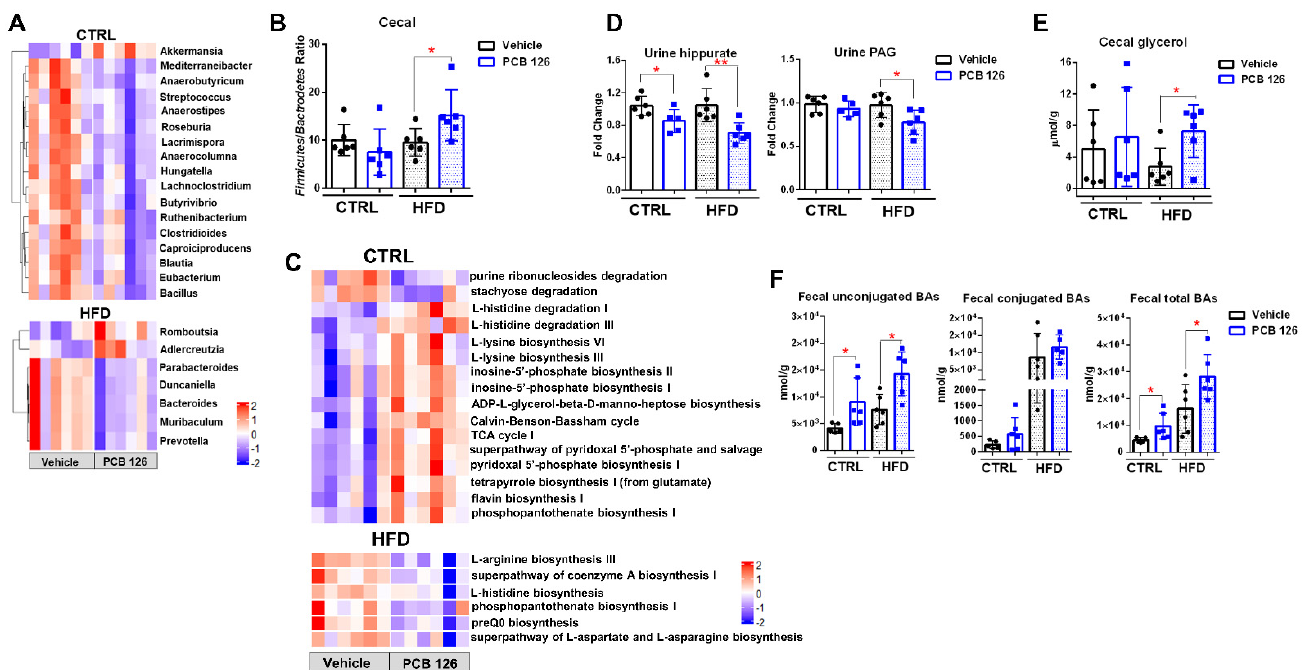
Figure 5. Effects of early life PCB 126 on bacteria community and metabolism in mice with CTRL or HFD. ( A ) Heatmap representation of the abundance of cecal bacteria from genera that were significantly changed from CTRL or HFD-fed mice with vehicle or PCB 126 exposure. ( B ) Ratio of Firmicutes to Bacteroidetes in cecal contents from CTRL or HFD-fed mice with vehicle or PCB 126 exposure. ( C ) Analysis of KEGG pathway abundance that significantly changed in the cecal microbiota from CTRL or HFD-fed mice with vehicle or PCB 126 exposure. ( D ) 1 H NMR analysis of urine hippurate and phenylacetylglycine (PAG) from CTRL or HFD-fed mice with vehicle or PCB 126 exposure. ( E ) 1 H NMR analysis of cecal glycerol from CTRL or HFD-fed mice with vehicle or PCB 126 exposure. ( F ) Quantitative UPLC-MS analysis of bile acids in the feces from CTRL or HFD-fed mice with vehicle or PCB 126 exposure. Values are means ± S.D. (n = 6 per group). * p < 0.05, ** p < 0.01 compared to